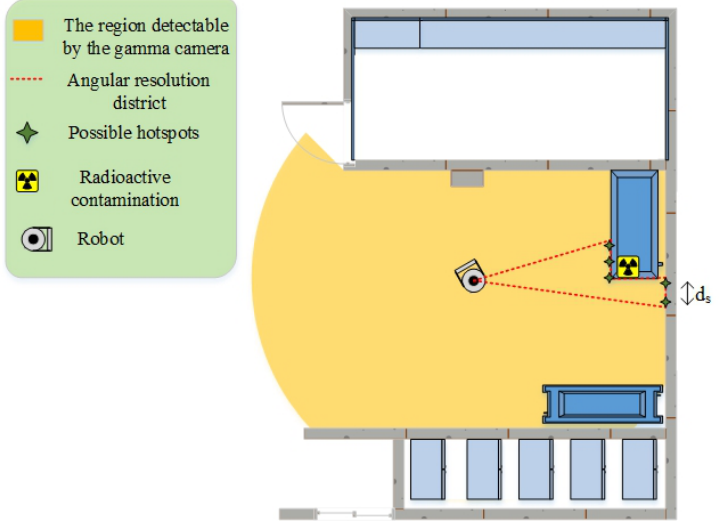
Figure 2. An example showing the possible radioactive hotspots in the contaminated area within a AR